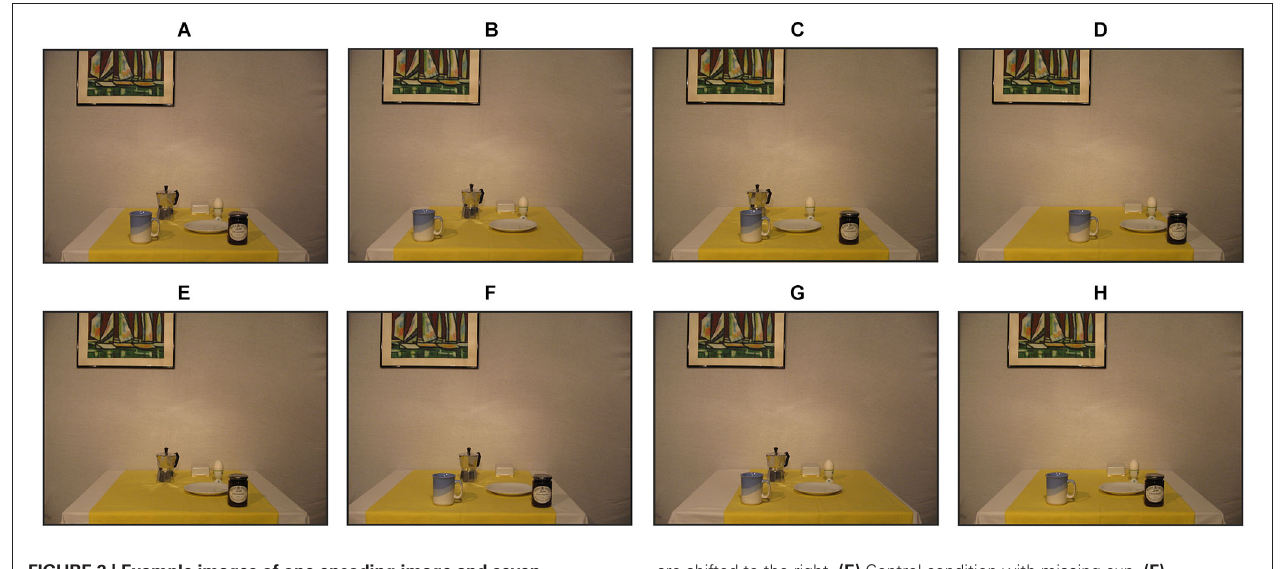
FIGURE 2 | Example images of one encoding image and seven corresponding test images. (A) Encoding image with all six objects. (B) Test image of the local 1 condition (loc1) with the marmalade jar missing and the cup shifted to the left. (C) Local 3 condition (loc3) with missing butter dish and espresso, egg and plate shifted to the left. (D) Example image from the local 5 condition (loc5): The espresso cooker is missing, all other objects